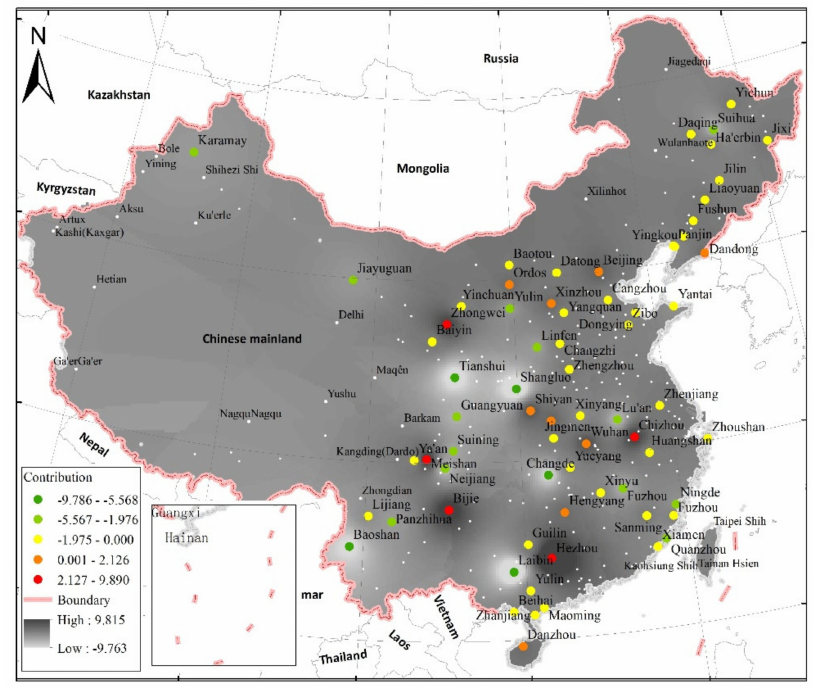
Figure A9. Contribution from the indicator ConMD (annual average consumption per capita of downtown) to land-use intensity revealed in the city-based